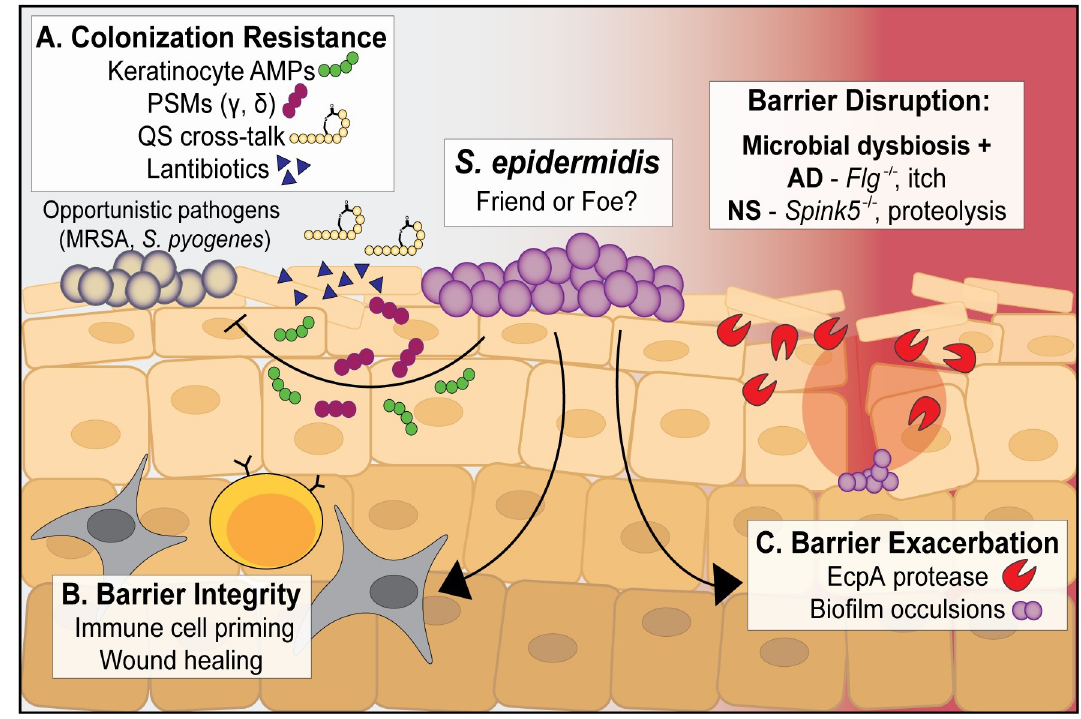
Fig 1. The ubiquitous skin commensal S . epidermidis positively and negatively impacts barrier homeostasis and integrity. (A) S . epidermidis phenol soluble modulins PSM γ and PSM δ can synergize with keratinocyte-derived AMPs to kill opportunistic skin pathogens like MRSA and Streptococcus pyogenes . S . epidermidis also makes anti-MRSA quorum sensing inhibitor peptides and a variety of small antimicrobials known as lantibiotics to mediate skin colonization resistance. (B) S . epidermidis lipoteichoic acid and some lipopeptides can dampen the inflammatory response to skin injury, accelerating wound healing. Early skin colonization with S . epidermidis is crucial for development of immune cell subsets including effector T cells and MAIT cells, and long-term S . epidermidis skin colonization may help the cutaneous immune system distinguish between commensal and pathogenic bacteria. (C) Certain S . epidermidis strains can “bloom” and exacerbate AD or NS skin lesions through production of the EcpA protease. Inflammatory S . epidermidis biofilms that occlude sweat glands have also been shown to exacerbate some AD lesions. AD, atopic dermatitis; AMPs, antimicrobial peptides; MAIT cells, mucosal-associated invariant T cells; MRSA, methicillin-resistant Staphylococcus aureus ; NS, Netherton syndrome; PSM, phenol soluble modulins; QS, quorum